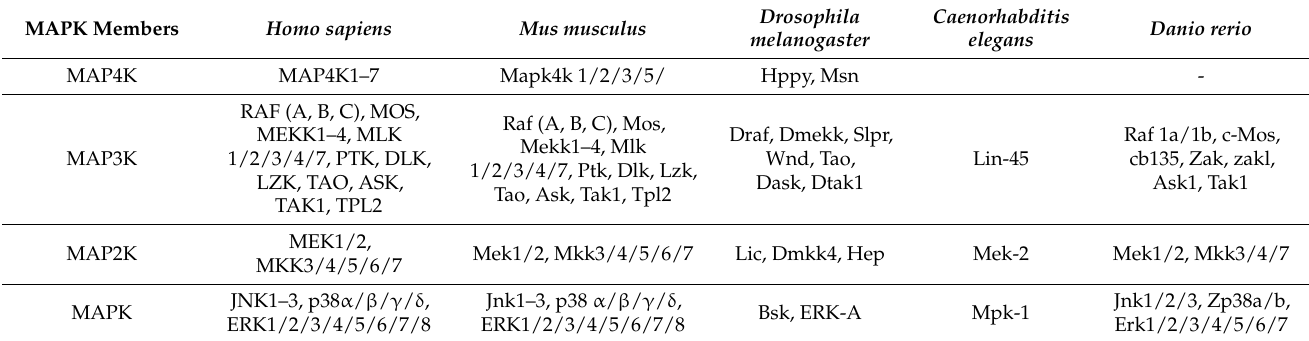
Table 1. List of MAPK members in human and commonly used animal